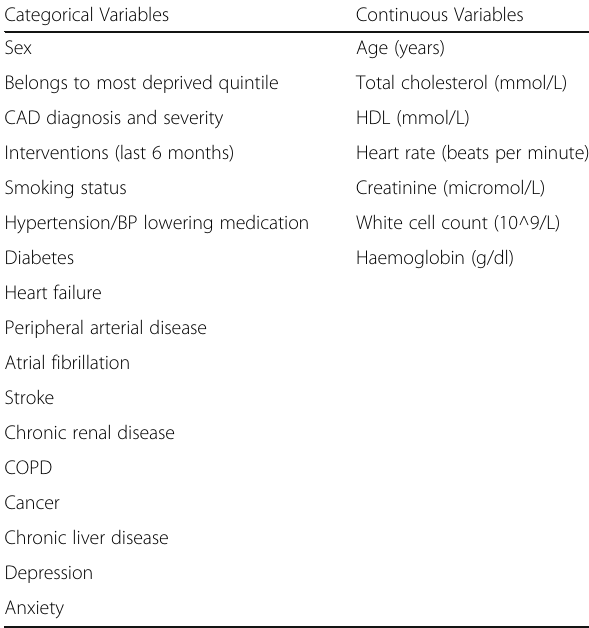
Table 1 Variables Included in the CALIBER 5-Year Risk